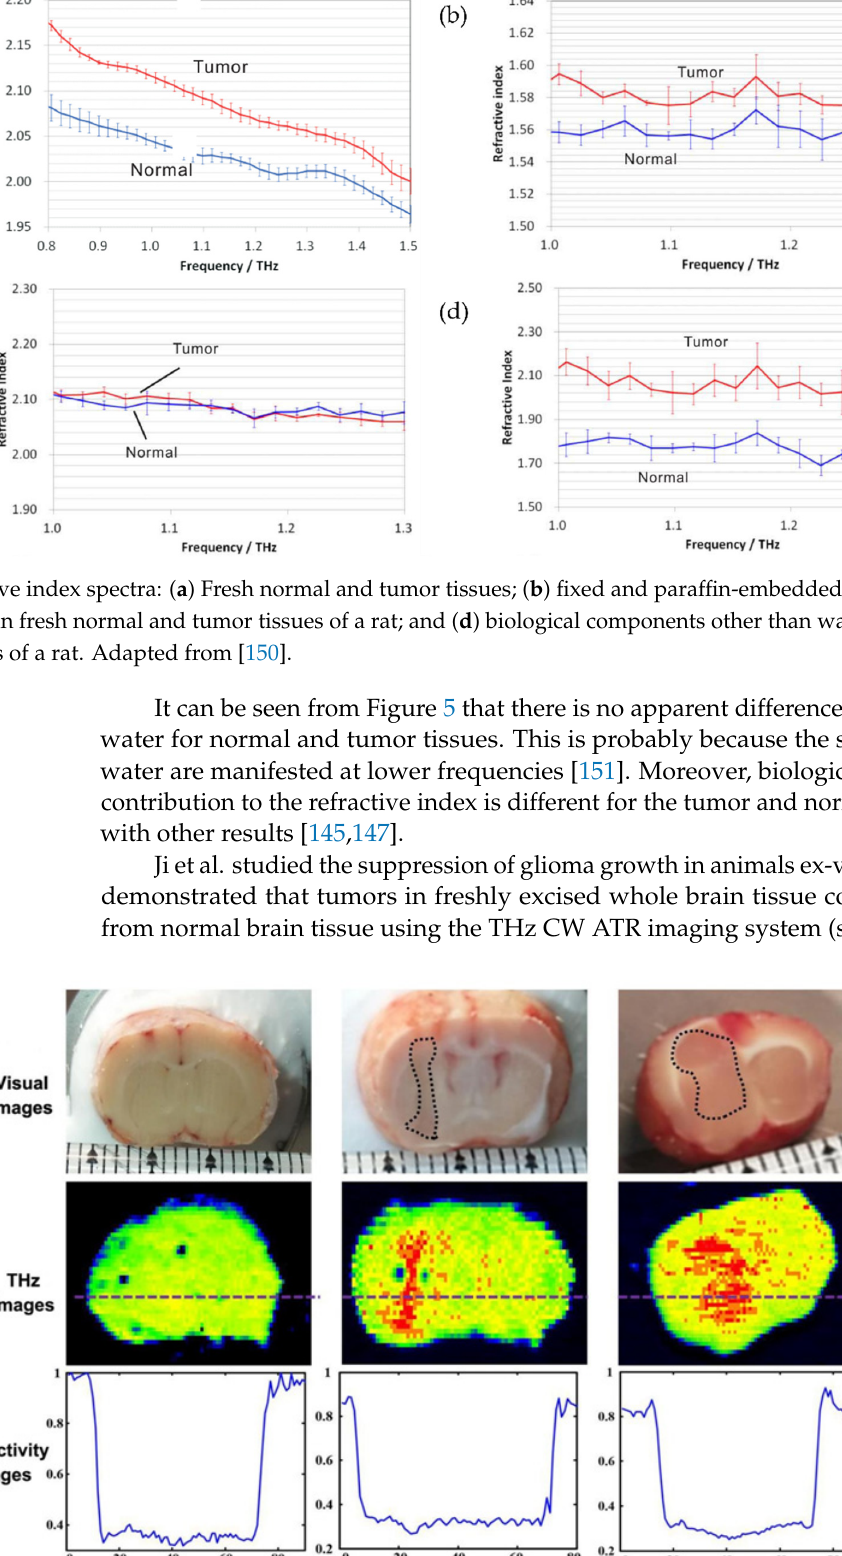
brain tissues without ( a ) and with ( b , c ) tumors. Reprinted from [152].